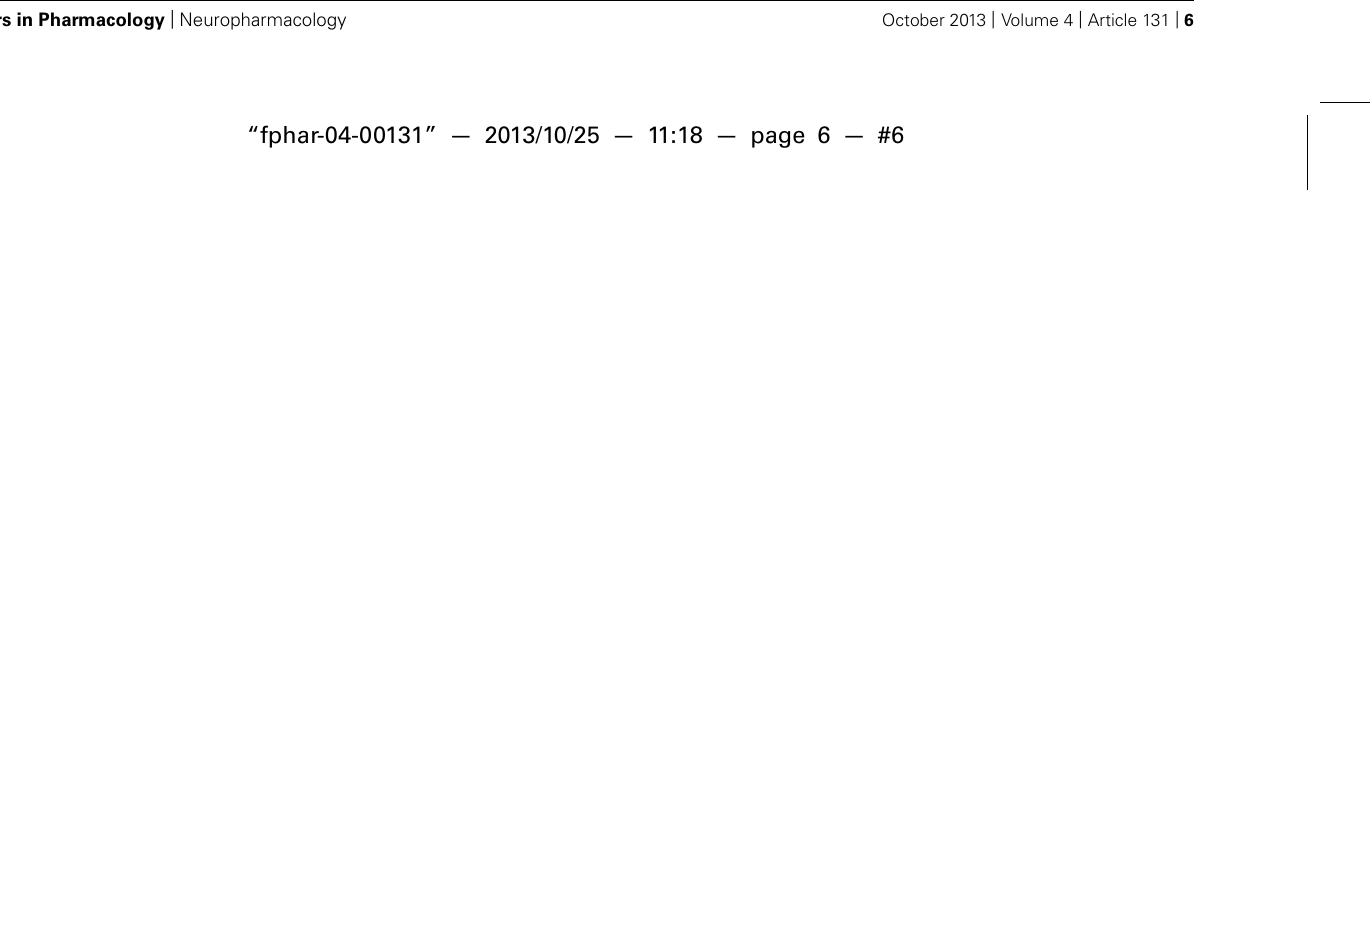
FIGURE 4 | Relationship between antidepressant-like response and hippocampal SERT and NET expression and affinity in P21, P28, and adult male mice. The magnitude of antidepressant-like response to the SERT blocker, escitalopram, increased with age but neither B max (A) nor K d (C) values for [ 3 H]citalopram binding to SERT varied significantly with age.The magnitude of antidepressant-like response to the NET blocker, DMI, as well as B max (B) and K d (D) values for [ 3 H]nisoxetine binding to NET remained